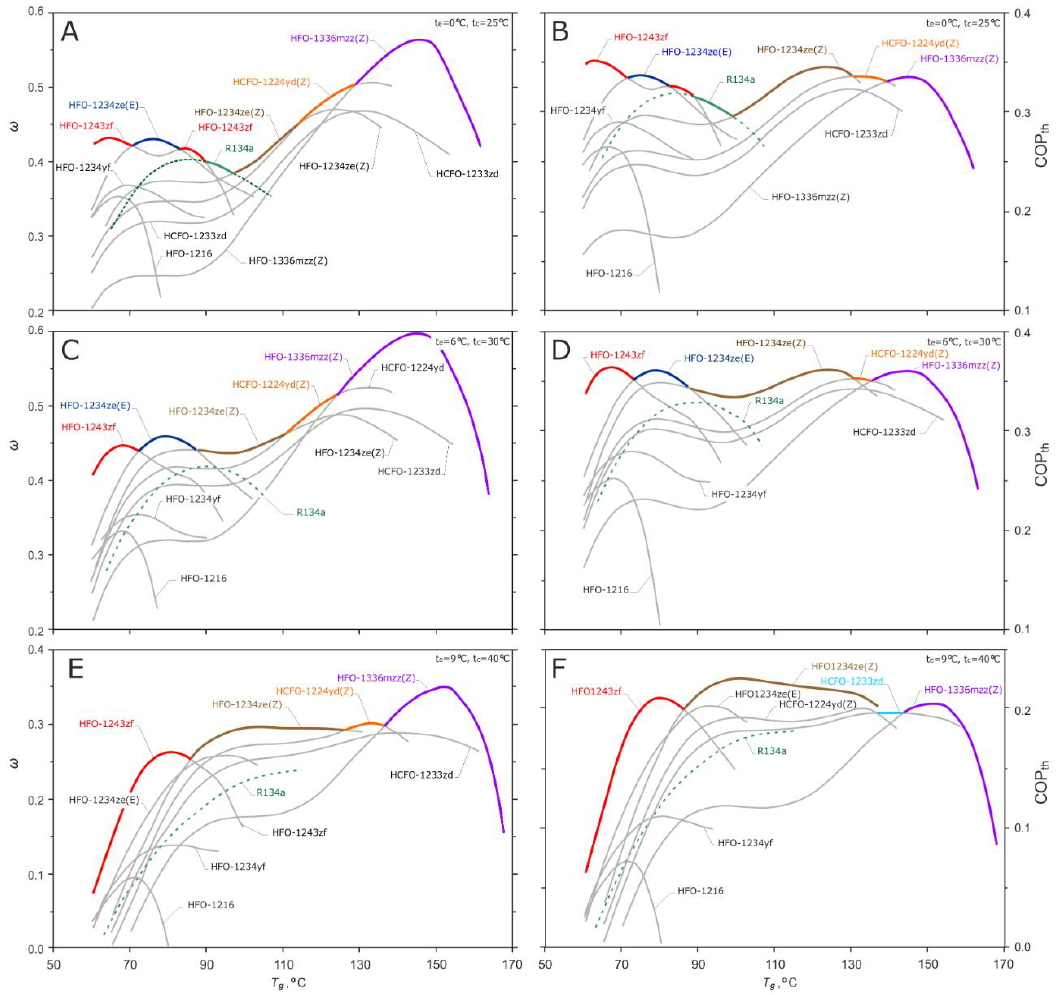
Figure 8. Calculated value of the ejector entrainment ratio ( left column ) and performance of the ejector cycle ( right column ) versus generator temperature for the assumed evaporation and condensation temperatures: ( A ) ω for t e = 0 °C, t c = 25 °C ; ( B ) COP for t e = 0 °C, t c = 25 °C ; (C) ω for t e = 6 °C , t c = 30 °C ; (D) COP for t e = 6 °C , t c = 3 0 °C ; (E) ω for t e = 9 °C , t c = 40 °C ; (F) COP for t e = 9 °C , t c = 40 °C .